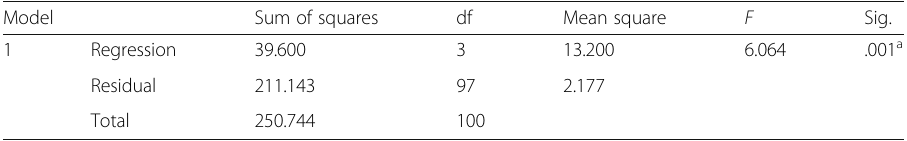
Table 8 ANOVA Model Sum of squares df Mean square F Sig. 1 Regression 39.600 3 13.200 6.064 .001 a Residual 211.143 97 2.177 Total 250.744 100